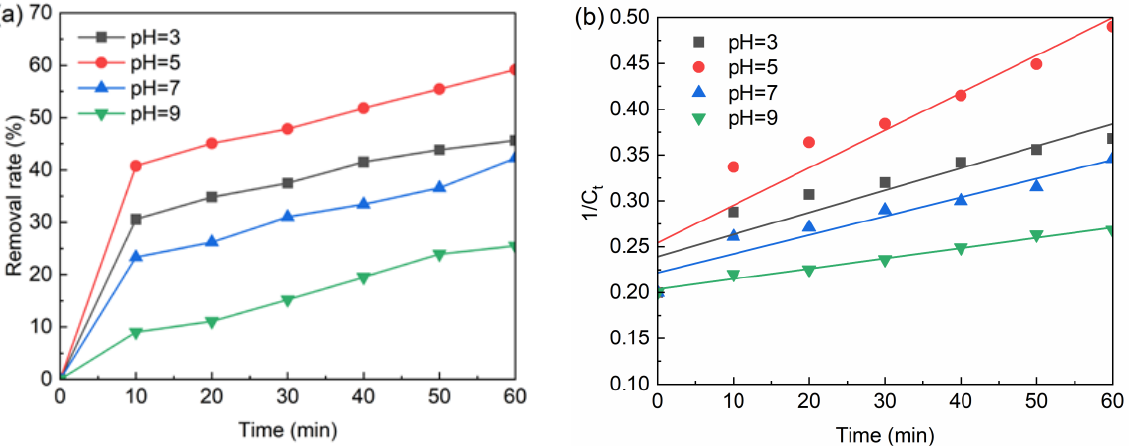
Figure 4. ( a ) The effect of temperature on BPA removal; ( b ) Tthe kinetic of BPA degradation at dif- ferent temperature. Conditions: pH = 6.8, [BPA] = 5 mg/L.